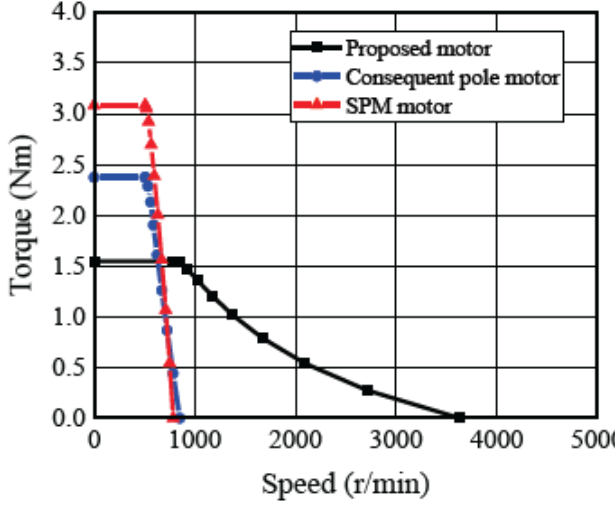
Figure 30. Comparison of N-T characteristics.